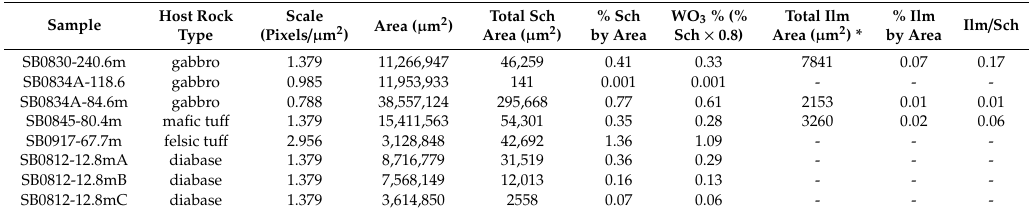
Figure 5. Micro-XRF compositional maps for sample from drill core SB0806 at 69 m showing distribution of ( A ) Mo, W, S, and Ca and ( B ) W, S, Ca, and K in metasomatically altered diorite. Note decrease in Ca concentration and increase of K concentration within main alteration selvage (boundaries marked by white dashed lines) and increasing towards vein with Ca-rich margins (red dashed lines). The distribution of Ca and K is consistent with the remobilization of K during the potassic alteration of wall rocks due to interaction with a mineralized fluid. Red boxes show the location of grains in Figure 8A,F. Table 1. Total measured scheelite (Sch) and ilmenite (Ilm) in